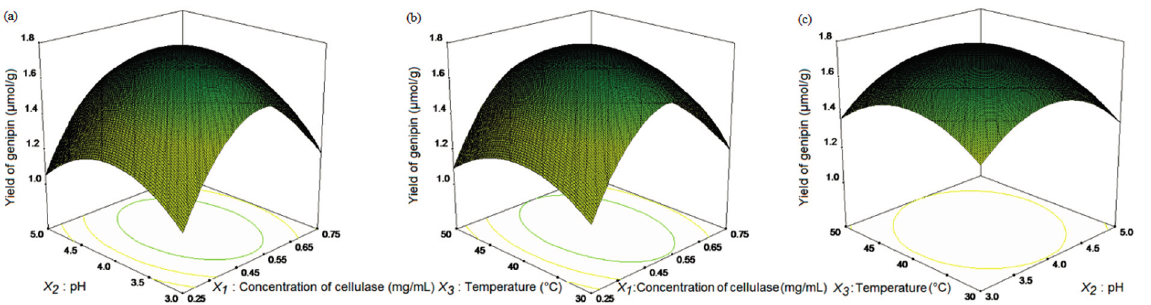
Figure 5. Response surface plot for maximal extraction yields of ginipin as a function of ( a ) enzyme concentration and pH; ( b ) enzyme concentration and temperature; and ( c ) pH and